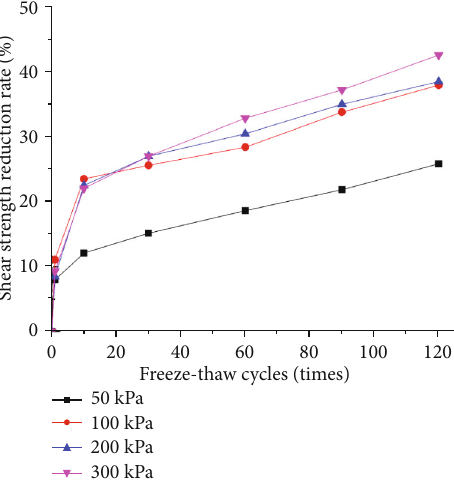
Figure 3: Reduction ratios of undrained shear strength of specimens under di ff erent conditions.